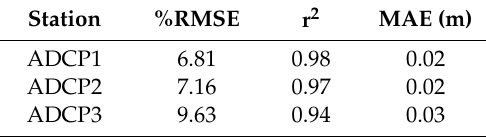
Figure 7. Comparison of velocity magnitude from numerical model with measurement data at ( a ) ADCP1 ( b ) ADCP2, and ( c ) ADCP3. Table 3. Comparison of velocity magnitude between simulated and measured data.